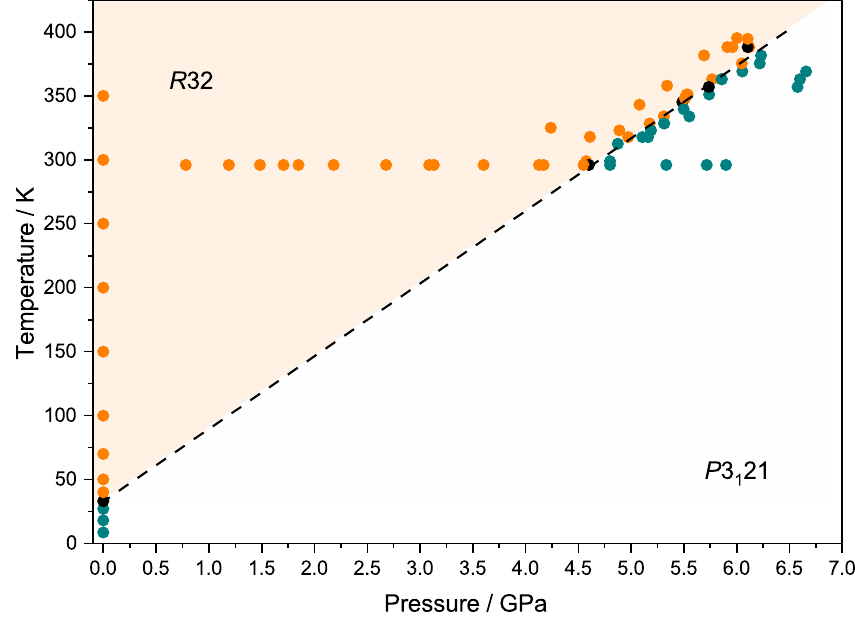
Figure 6. p–T phase diagram of TbFe 2.46 Ga 0.54 (BO 3 ) 4 crystal. Color code: orange—phase R 32, dark cyan—phase P 3 1 21, black—phase